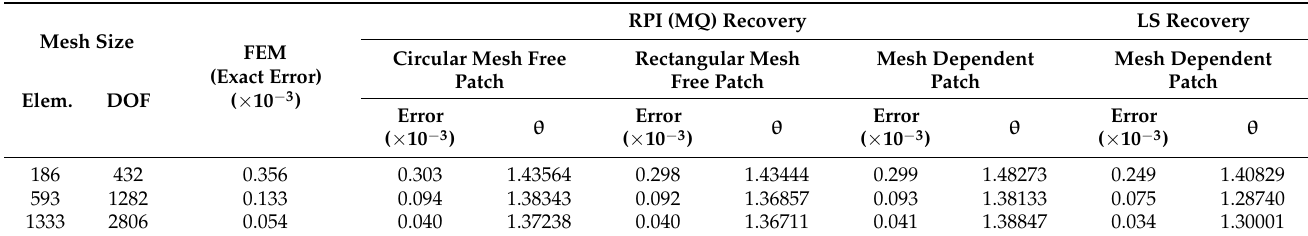
Table 9. Error convergence and global effectivity ( θ ) obtained for RPI (MQ) and least square based displacement recovery techniques (quadrilateral, L 2 norm).